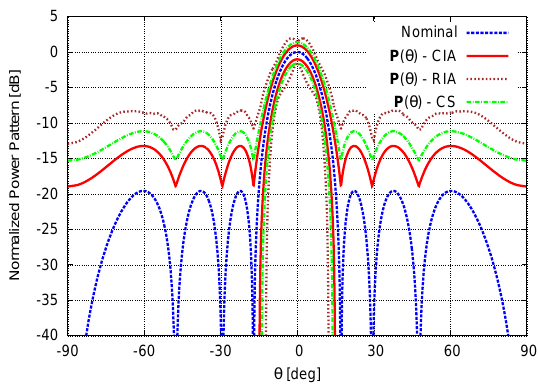
Figure 8. Multiple Mutual Coupling ( N = 8, d = λ SLL ref = − 20 dB)—Nominal power pattern and interval power pattern bounds predicted by the CIA, the RIA, and the CS